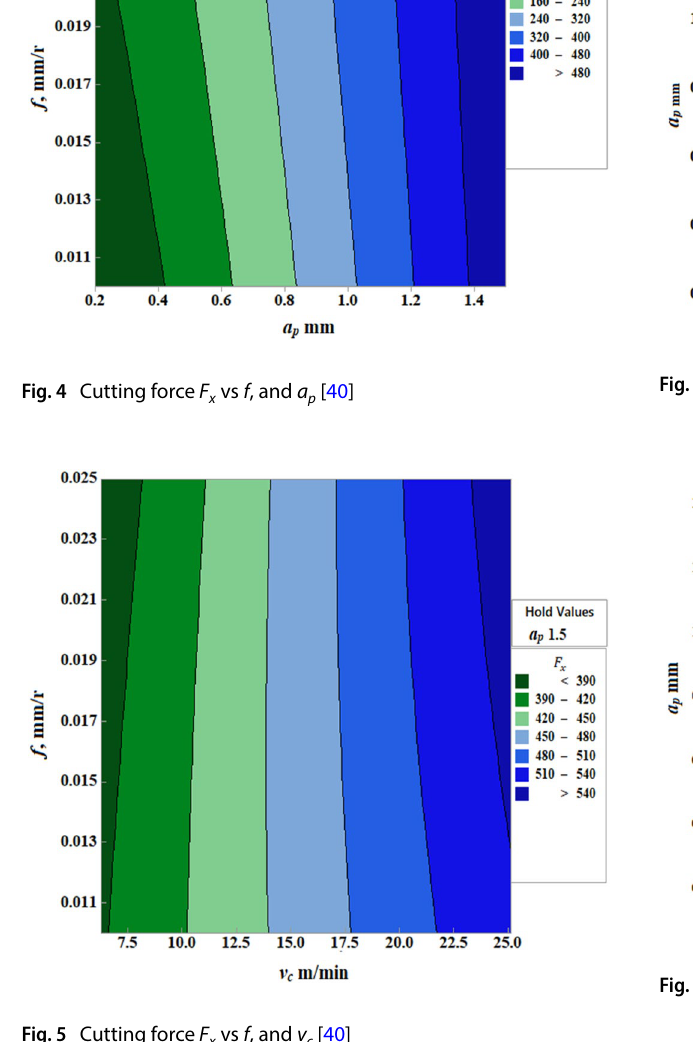
Fig. 5 Cutting force F x vs f , and v